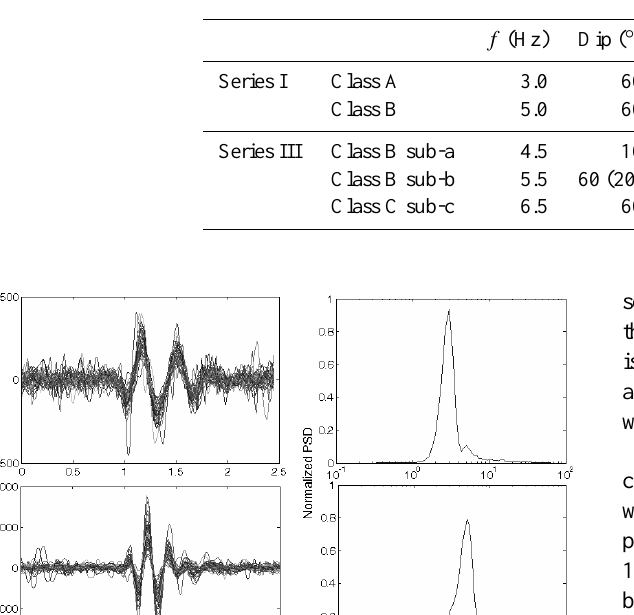
Fig. 2. Samples of the time series of seismic tremor (vertical component) registered at the Dashgil mud volcano. (a) Series I measured on June 2006 (in the small inset aa, a magnification of “transient events” (TEs) observed in the series is shown); (b) Series II (June 2006); (c) Series III (July 2007); magnification of a TE for this last series is reported in the inset cc. In this last inset, light gray and black lines respectively report the original and the filtered (i.e. modulated by RL 4 ) signals. Table 1. Summary of TEs’ main features in the two time series of tremor measurements at the Gryphon area. For each Class and sub-class of events, characteristic frequency ( f ), polarization dip ( ◦ from the vertical), polarization azimuth ( ◦ from the reference direction), number of TEs in the relevant series ( N ), time rate of TEs (number per hour) and radius estimate of the bubble responsible for the relevant TE are reported.